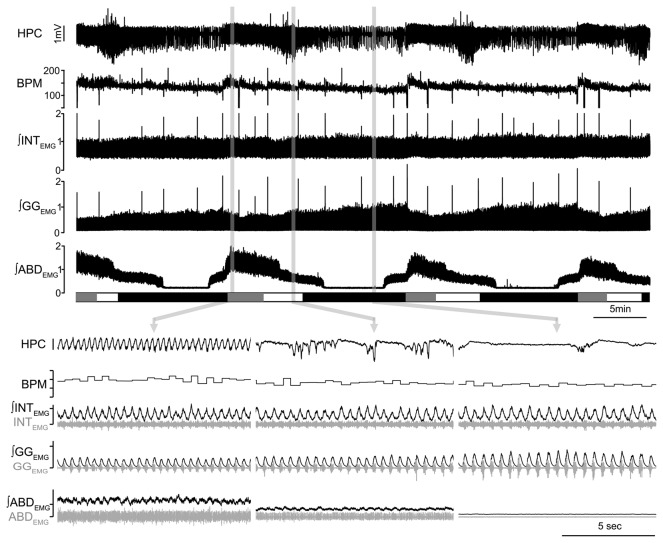
State dependent modulation of breathing in urethane anesthetized mice. A) Long-term EEG recording at the HPC site and corresponding respiratory frequency (breath per minute, BPM) and rectified and integrated activity of intercostals (INT), genioglossus (GG) and abdominal (ABD) muscle EMG activity across spontaneous brain state alternations. Schematic block at the bottom of the plot indicate time spent in REM-like (grey), transition (white) and SWS-like (black) states. B) Details of the HPC trace, BPM and raw and integrated traces of INT, GG and ABD EMG in REM-like (left), transition (centre) and SWS-like states.